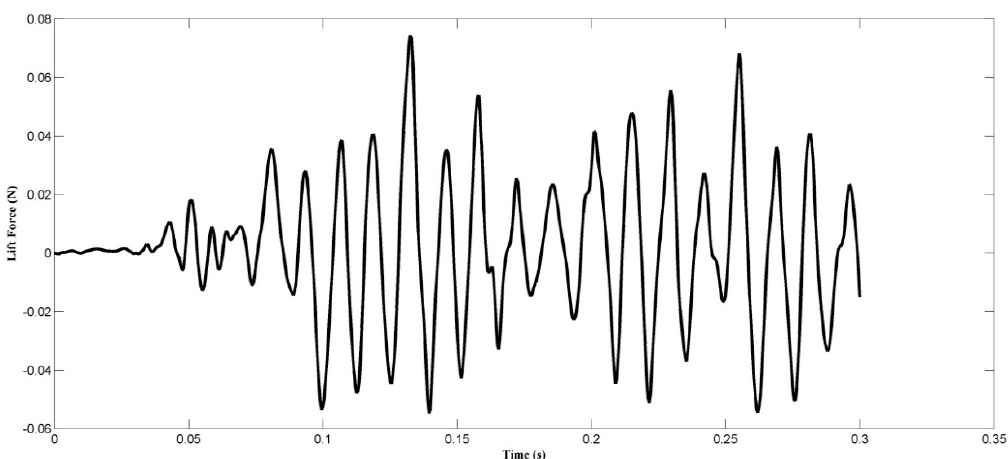
Figure 16. Graph lift force vs time at 19 m/s.